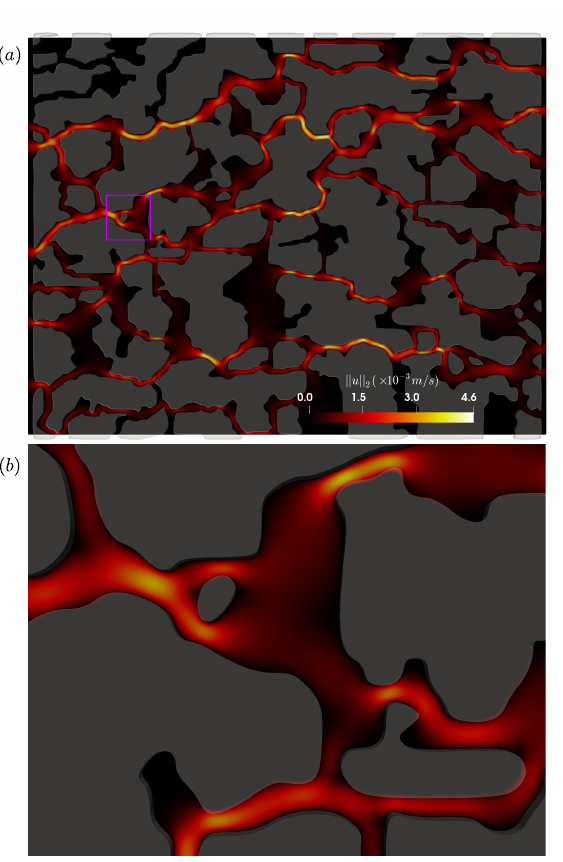
Figure 21. Contours of || u || 2 (in m/s) at the steady state. The STL triangulation is also shown here in light gray. ( a ) Whole computational domain, ( b ) zoomed view of the purple square as shown in ( a